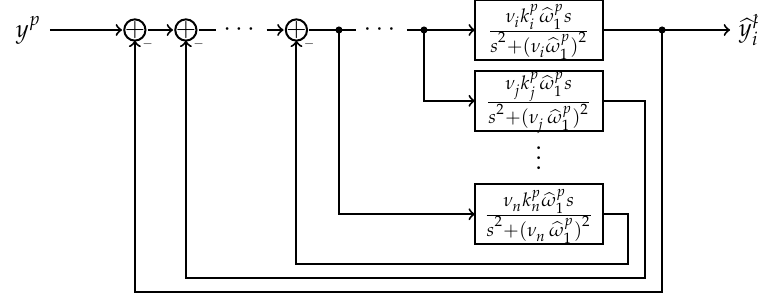
Figure A1. Block diagram of (13) using transfer